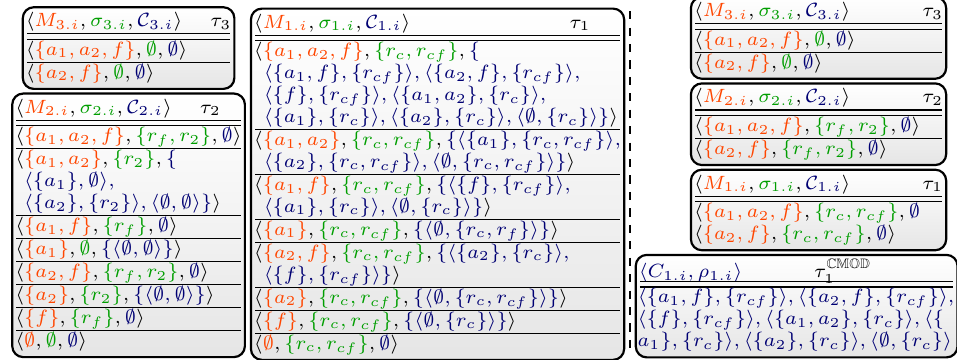
Figure 5. Selected DP tables after DP SINC ( left ) and after M - DP SINC ( right ) for TD T